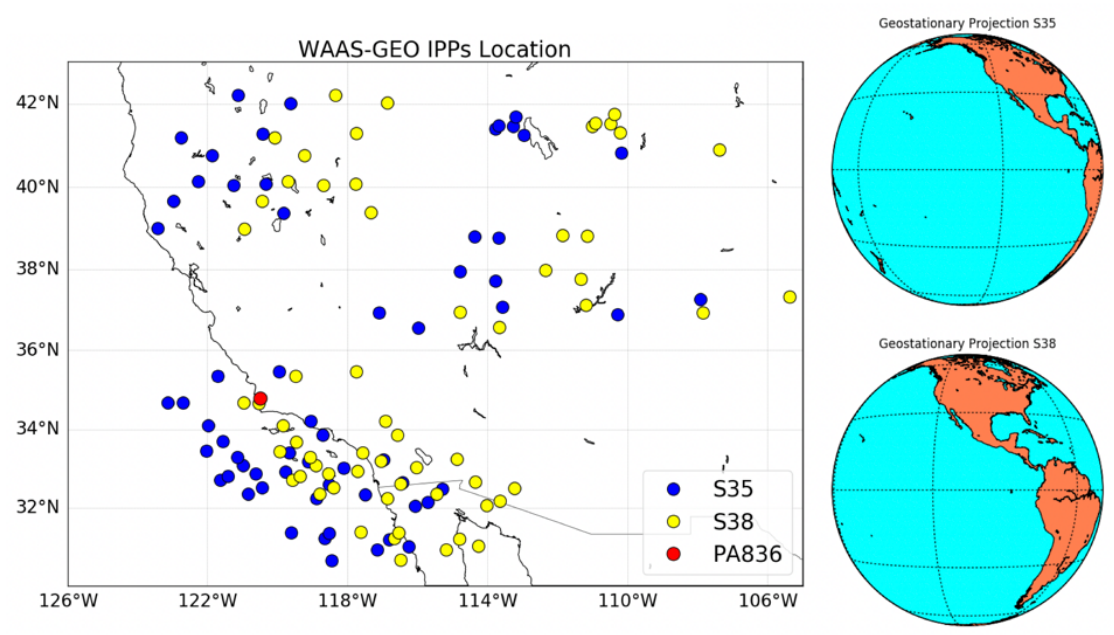
Figure 1. ( left ) Map showing the IPPs location for satellites S35 ( blue dots ) and S38 ( yellow dots ) seen from the 62 GNSS stations. The IPPs for GEO satellites can be considered to be fixed over time. The red dot represents the location of the ionosonde site PA836. ( right ) Two maps representing the Earth as seen from WAAS-GEO satellites S35 and